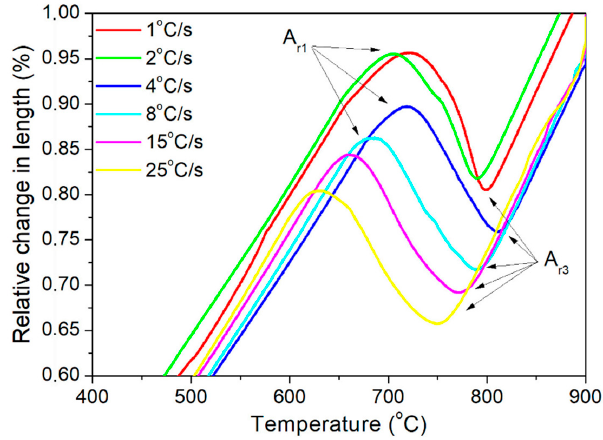
Figure 4. Dilatometric curves of undeformed steel samples at different cooling rates.